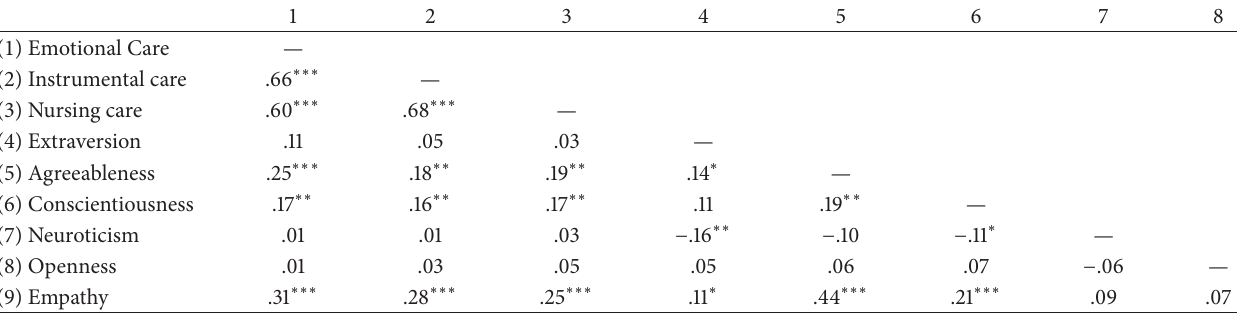
Table 3: Correlations among willingness to provide care variables, NEO, and empathy.